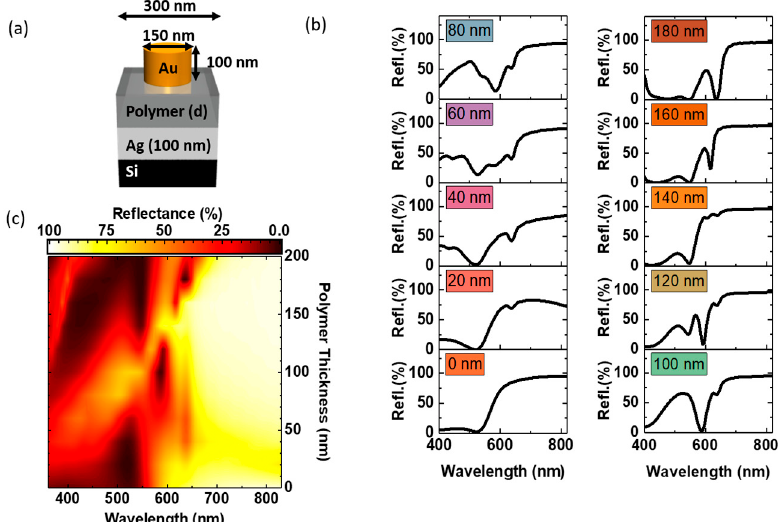
Figure 1. ( a ) Schematic of the hybrid nanostructure unit cell: Square arrays (300 nm pitch) of gold nanodiscs (100 nm high and 150 nm in diameter) on a back-reflector substrate consisting of a polymer thin film on top of a 100 nm thick silver (Ag) layer on silicon. ( b ) Simulated reflectance spectra of the hybrid structures for increasing polymer spacer thicknesses. The individual generated colours (sRGB) are displayed as insets. ( c ) Simulated reflectance as function of polymer thickness.